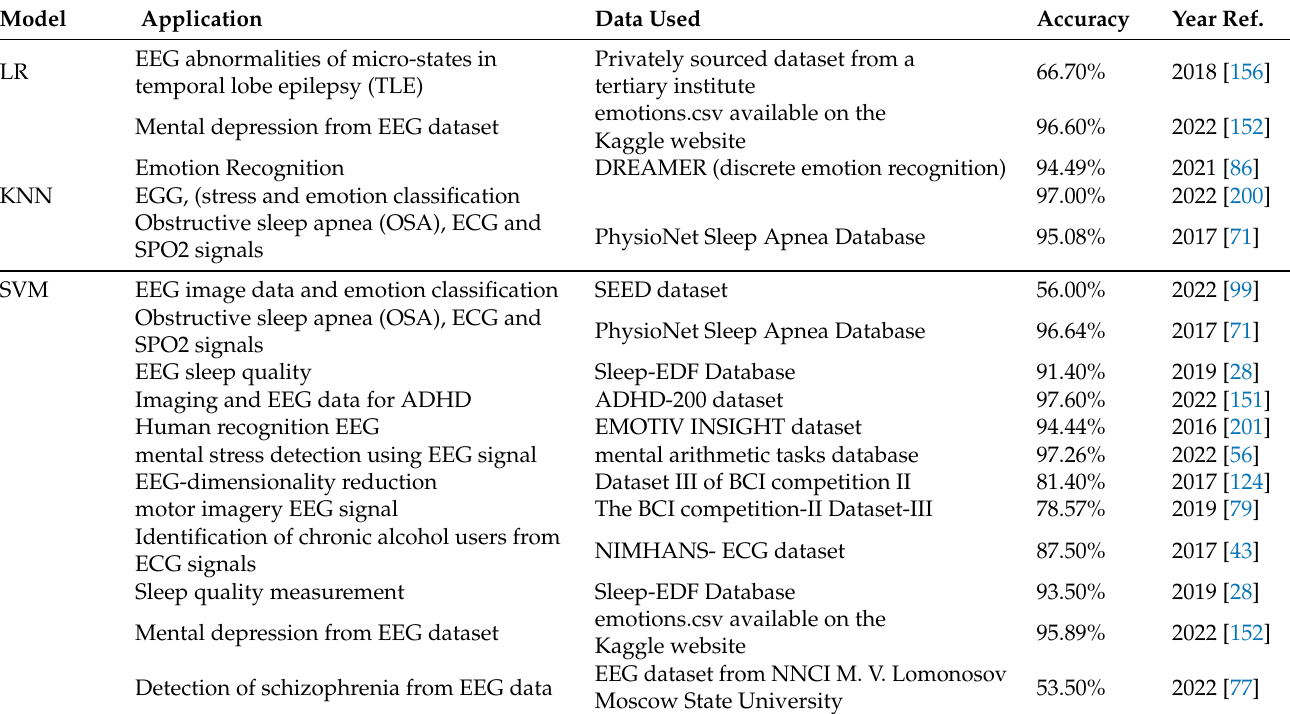
Table 5. A summary of machine learning-based studies for classification and prediction of PSG